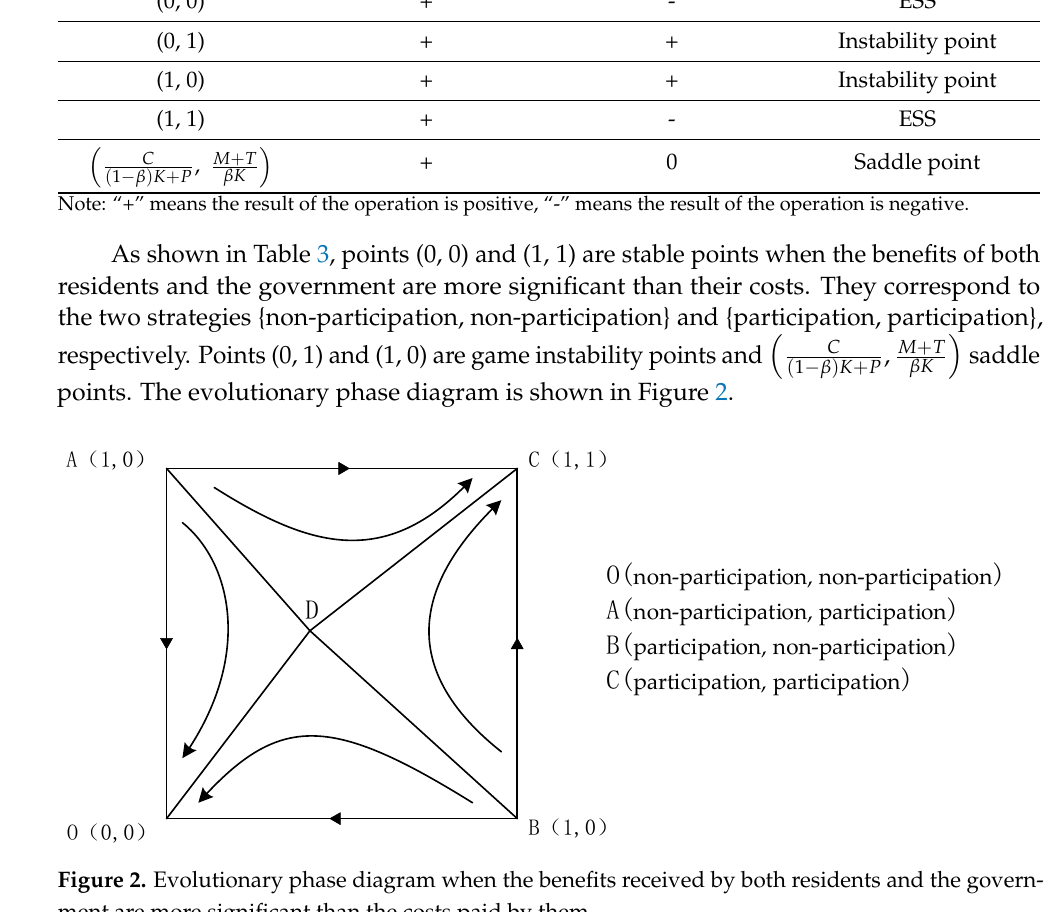
Figure 1. Evolutionary phase diagram when the expected benefit to one of the residents and the government is less than the cost to them.